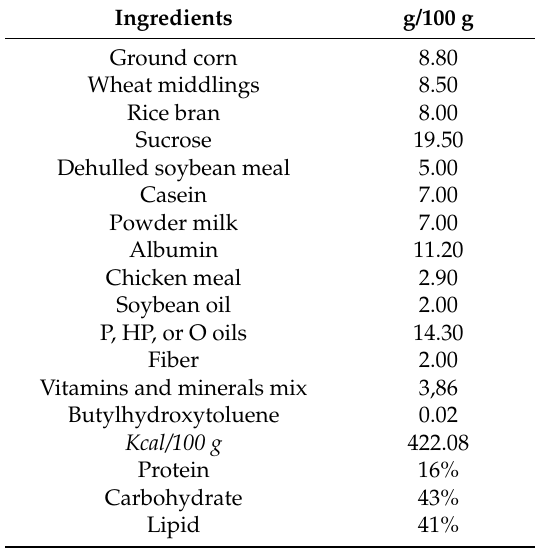
Table 3. Experimental diet composition shown as g/100